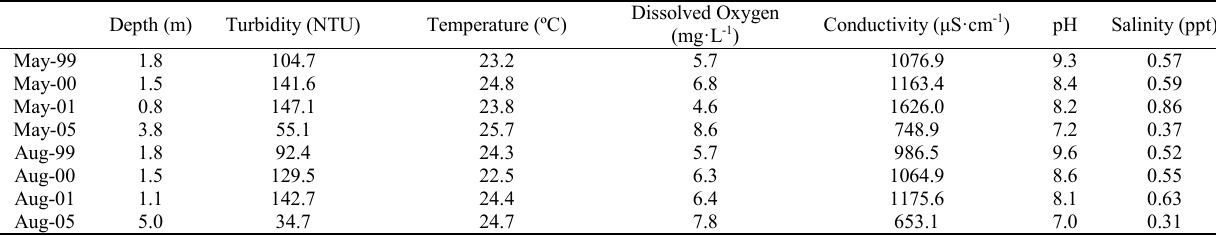
Table 2. Environmental variables mean values in Lake Chapala at different